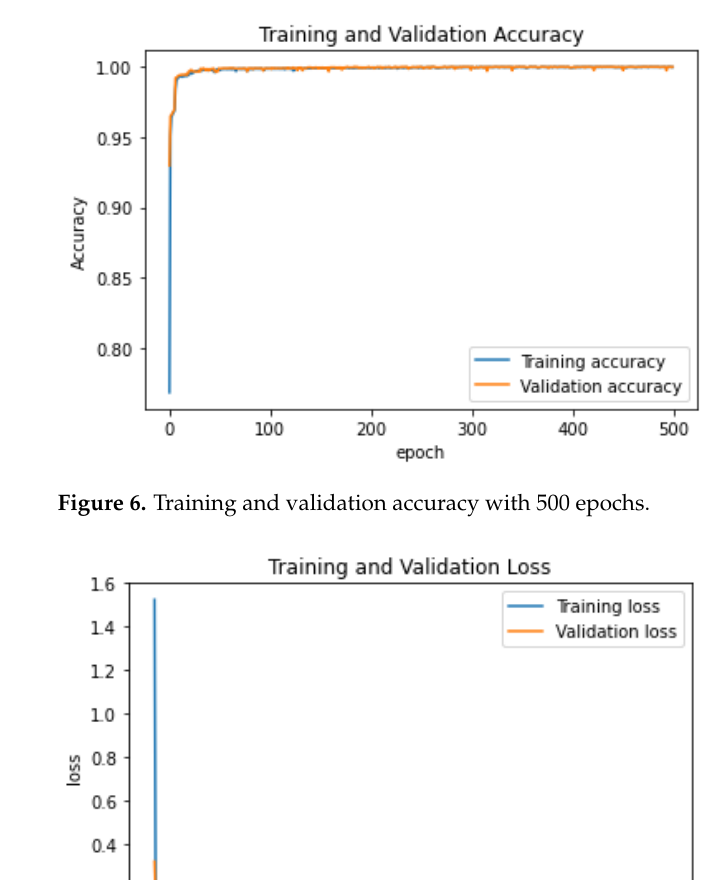
Figure 5. Training and validation loss with 100 epochs.